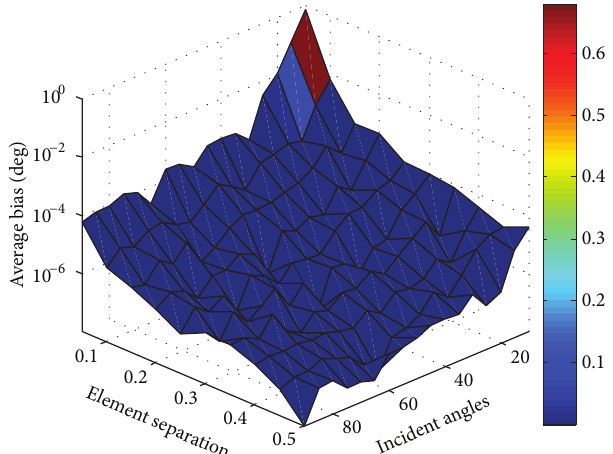
Figure 3: Summary of DOA estimations using MPM for a four- element ULA with interelement separation varying from 0.05𝜆 to 0.5𝜆 . Two equal-power incoming signals are from the directions of = 10 ∘ to 90 ∘ and 𝜙 = 𝜙 + 1 ∘ with an SNR of 5 dB. The step size 𝜙 1 2 1 of Δ𝜙 1 = 5 ∘ is considered. The figure shows the average biases of the estimated